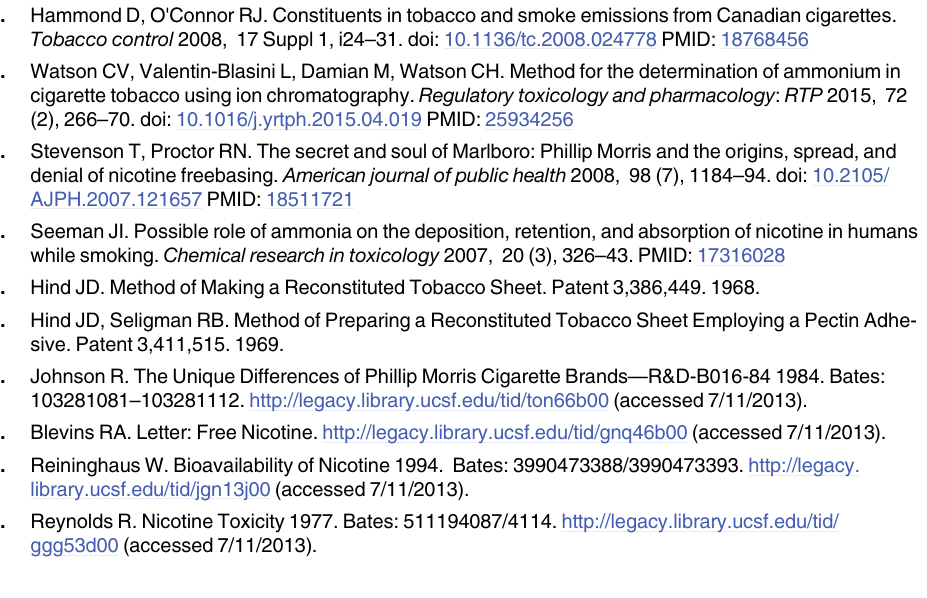
S1 Table. Average ammonia in mainstream cigarette smoke data (ISO and CI smoking con- ditions) for 50 commercial brands analyzed (n = 7). S2 Table. QC characterization data for the 3R4F research